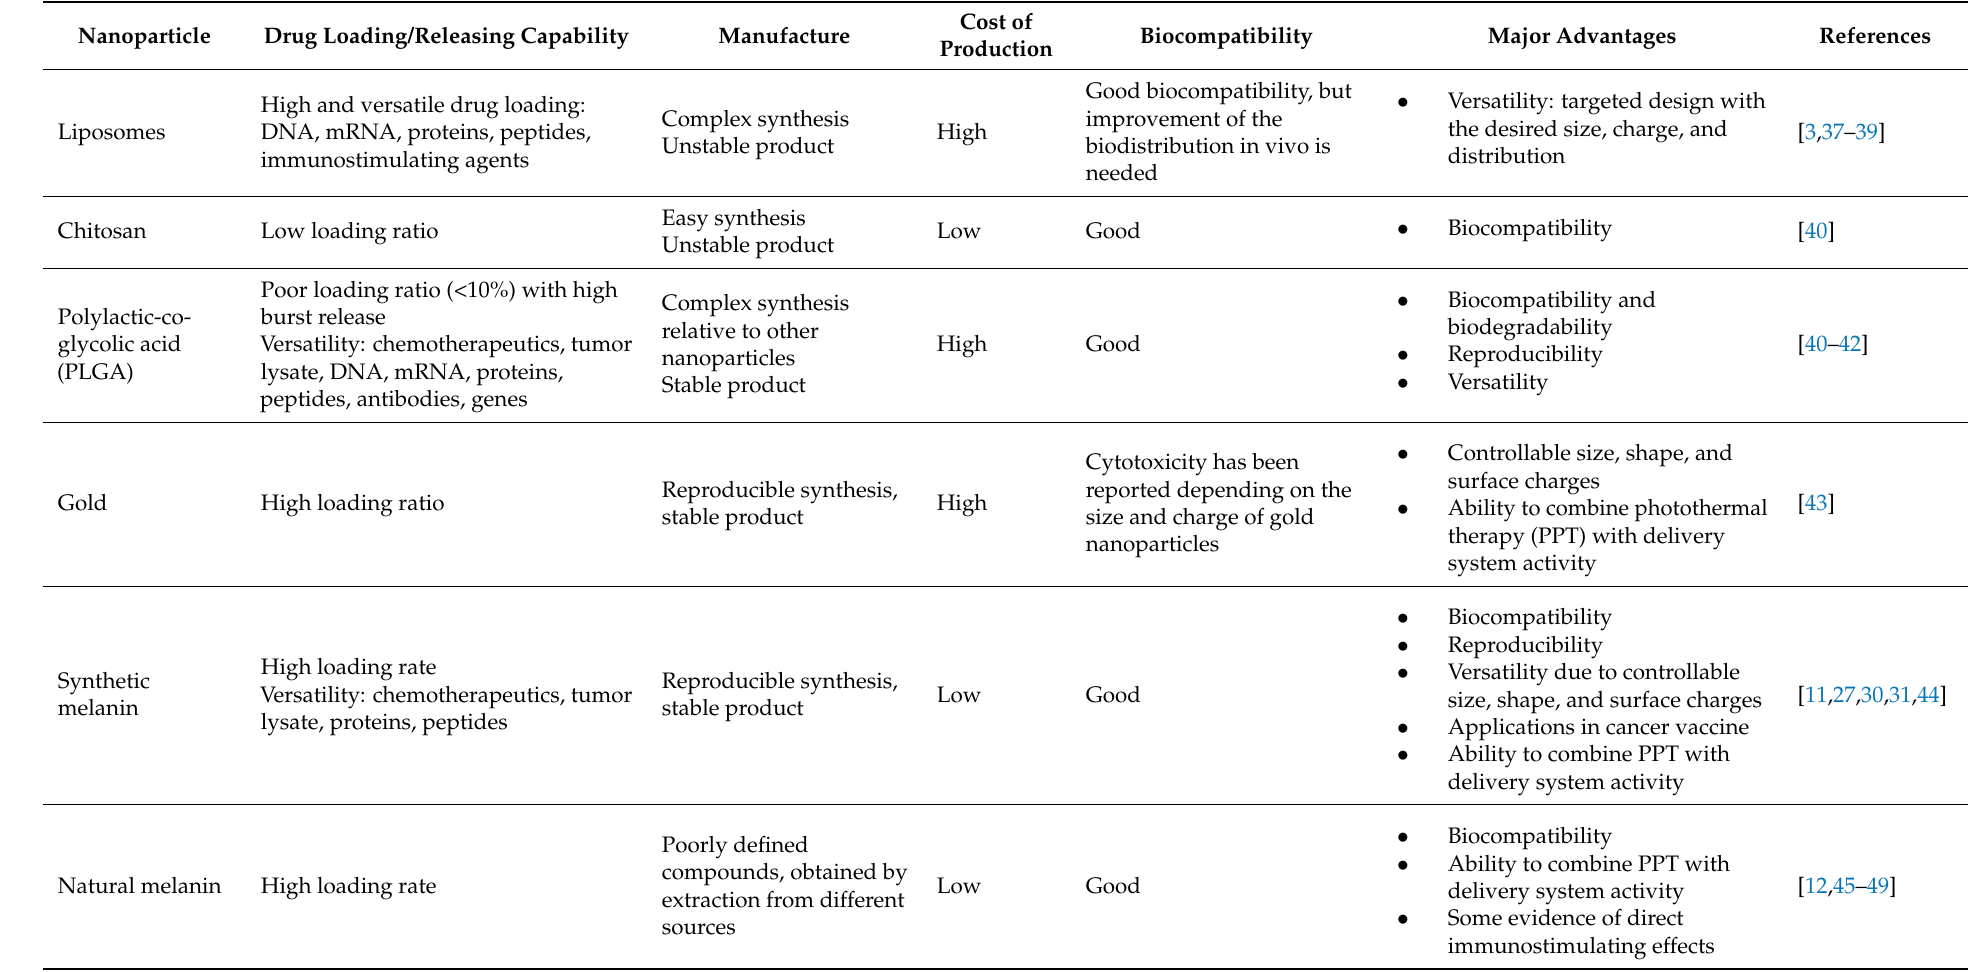
Table 1. Characteristic and advantages of the principal nanoparticles under development in cancer